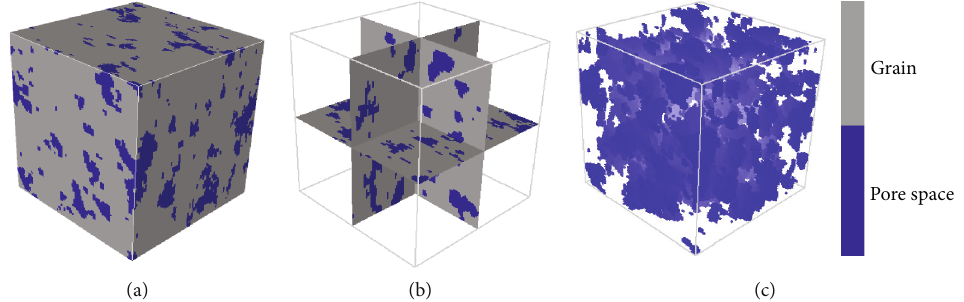
Figure 11: The target image of sandstone: (a) exterior; (b) cross-section ( X = 40 , Y = 40 , and Z = 40 ); (c) pore space.